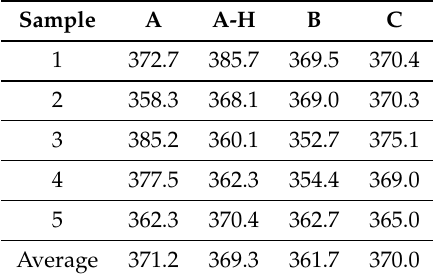
Table 3. Vickers hardness number of Ti6Al4V.